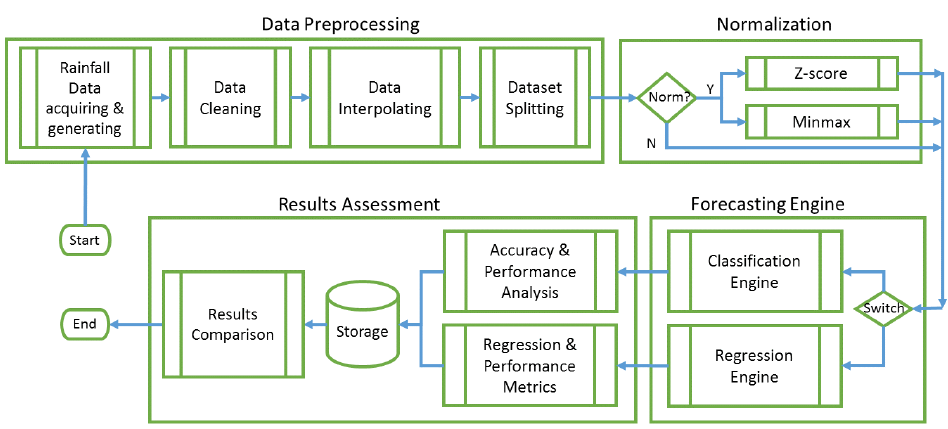
Figure 2. The illustration of a generic computing framework for regional rainfall